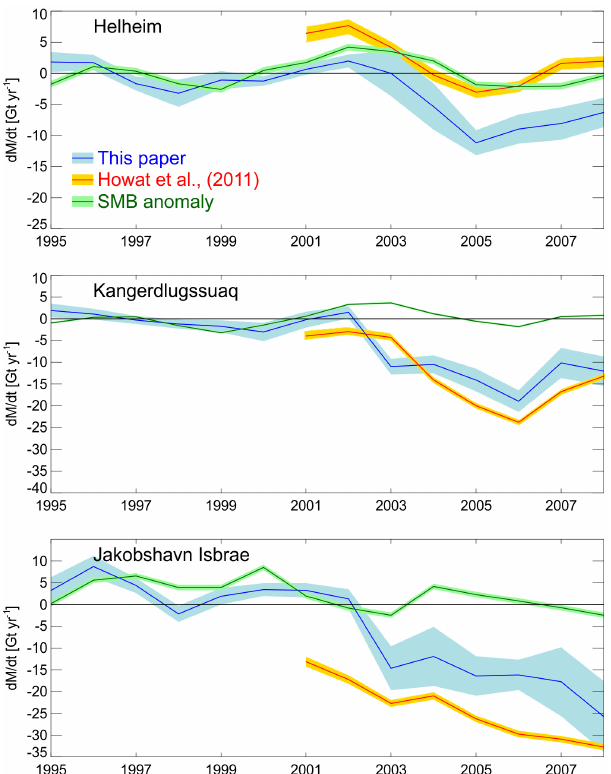
Figure 9. ˙ M for three major outlet glaciers – Kangerdlugssuaq, Hel- heim, and Jakobshavn Isbræ– over the period of interest (blue). For comparison, also shown are the mass balance estimates from the IOM from Howat et al. (2011) (red), resampled to our temporal resolution using a moving 36-month window, and SMB anomalies from RACMO2